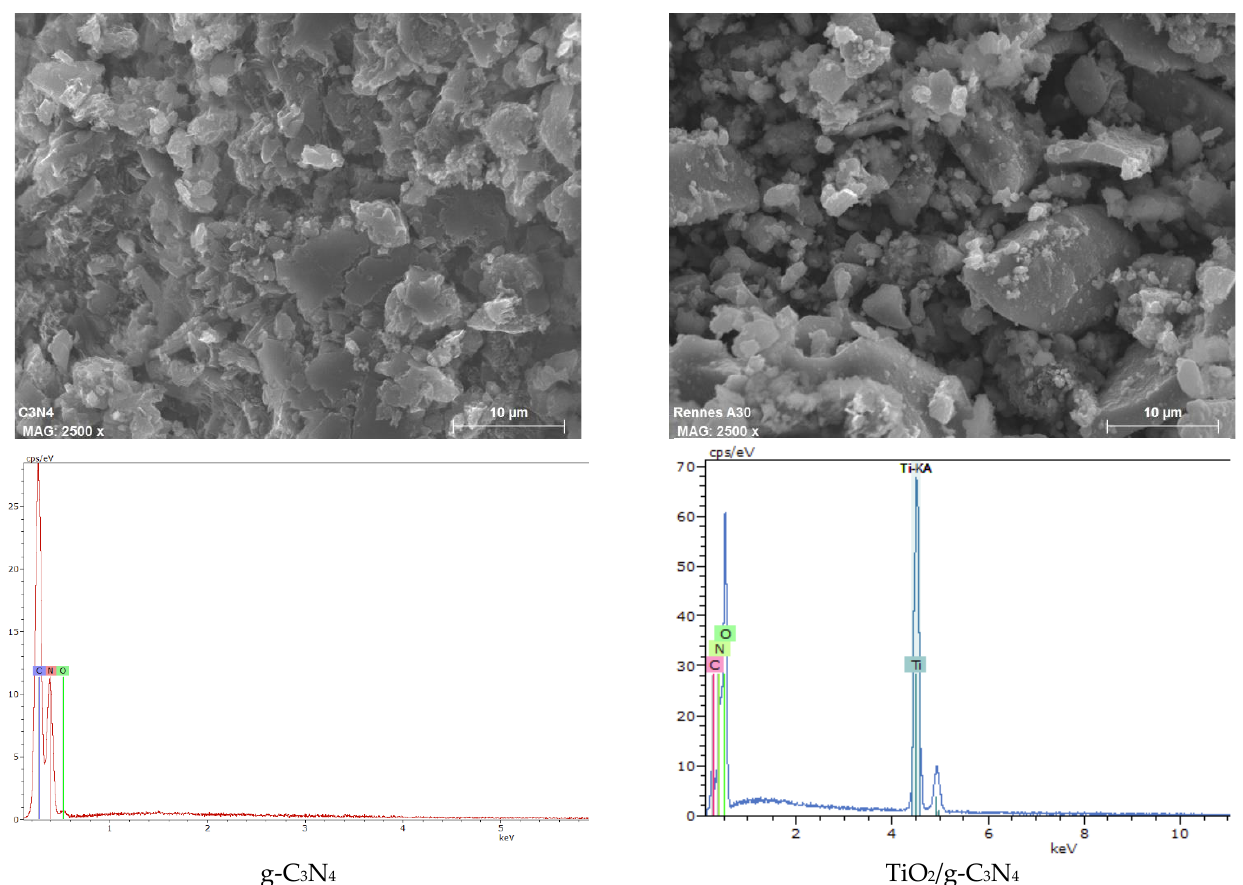
Figure 2. SEM images with EDX spectra of g-C3N4 and TiO 2 /g-C 3 N 4. The crystallinity structure of the synthesized materials g-C 3 N 4 and g-C 3 N 4 modified TiO 2 nanocomposites were characterized and the results were shown in Figure 3a. The XRD pattern of TiO 2 /g-C 3 N 4 revealed numerous peaks at 25.3°, 37.8°, 48.1°, 54.0°, 55.1°,